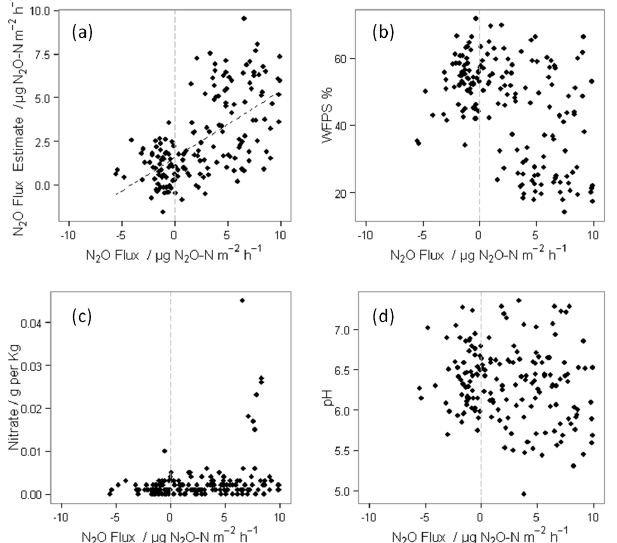
Figure 4. Multiple linear regression was carried out to correlate all N 2 O fluxes measured below 10µgN 2 O-Nm − 2 and the soil prop- erties measured from these locations (a) (see Table 2). Individ- ual comparisons with the three strongest correlating properties are shown (b, c, d) . Table 2. Multiple linear regression correlation of soil properties and